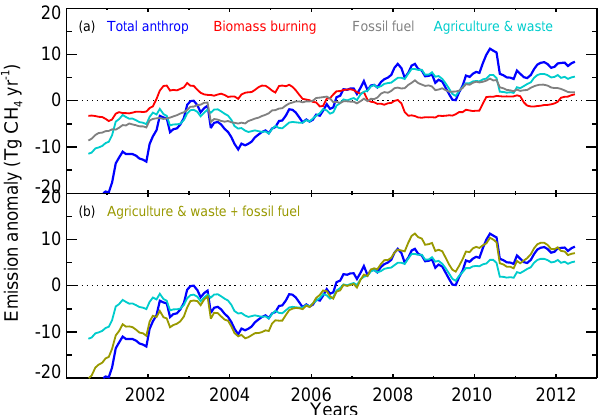
Figure 3. The 12-month running mean of global annual methane anthropogenic emission anomalies (Tg CH 4 yr − 1 ) inferred by the ensemble of inversions (only mean values of the ensemble are rep- resented) for (a) total anthropogenic, biomass burning, fossil fuel, and agriculture and waste sources. On the (b) panel, total anthro- pogenic, and agriculture and waste source anomalies are recalled on top of the sum of the anomalies from agriculture, waste, and fossil fuels